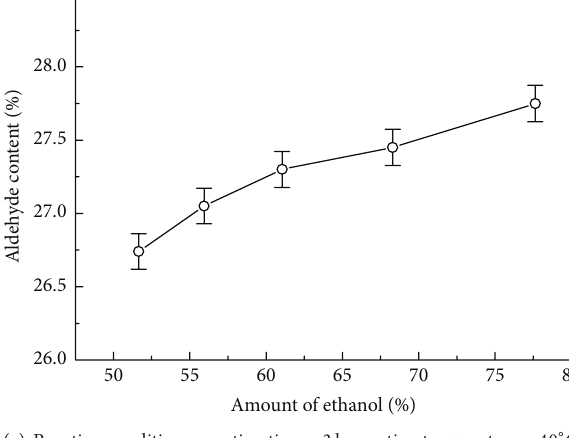
(e) Reactionconditions:reactiontime=3h,reactiontemperature=40 ∘ C, pH = 4, and amount of sodium periodate = 30 % Figure 1: Effect of reaction time, reaction temperature, pH, amount of sodium periodate, and amount of ethanol on the aldehyde content of